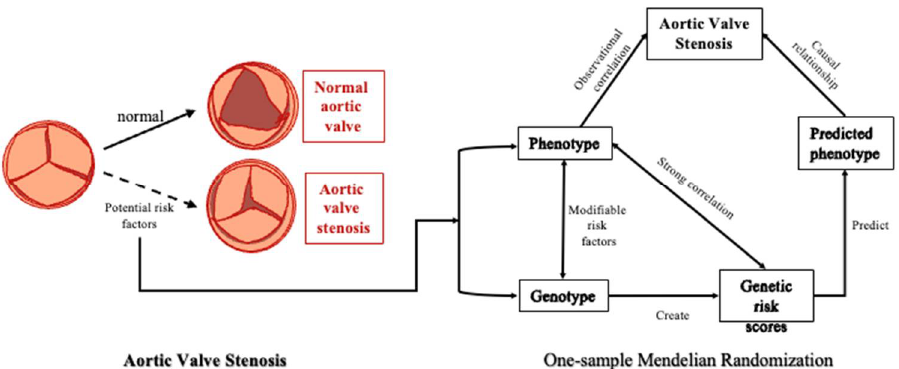
Figure 1. The Aortic Valve Stenosis Diagram. A normal tricuspid valve, known as the aortic valve, can open or close, depending on blood volume. An abnormal aortic valve that does not open properly can block blood flow and result in systemic ischemia. The procession of one-sample Mendelian randomization analysis. The three main steps of Mendelian randomization: Firstly, the genetic tool and the corresponding phenotype perform regression, which can only be carried out in the next step under significant circumstances; Secondly, the predicted value of phenotype was predicted using the regression results. Third, regression was performed using the predicted phenotypes and outcomes, and the statistically significant condition and direction of risk (consistent with the first step) were examined.